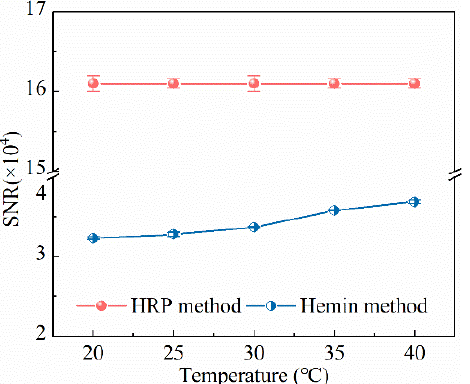
Figure 6. The results of two methods under different reaction temperatures.